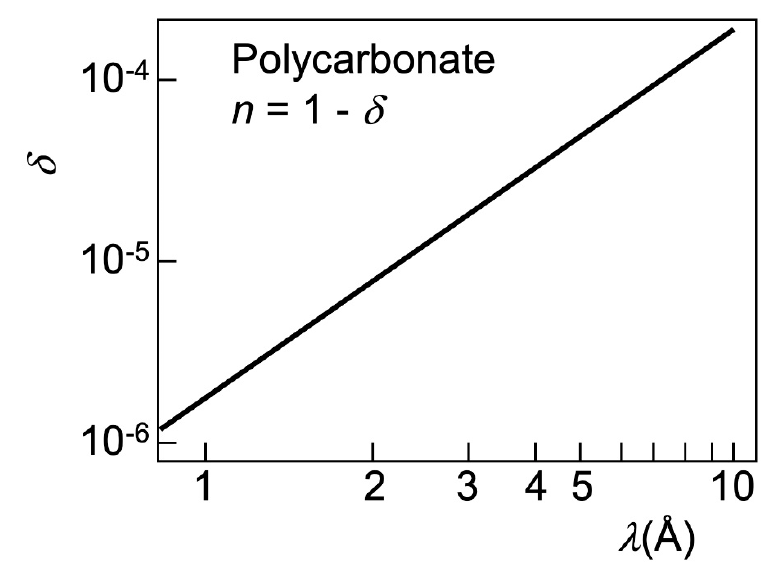
Figure 10. Refractive index of polycarbonate as a function of the wavelength in the X-ray range. These results are representative of the general behavior and magnitudes for different materials. Data from [17].